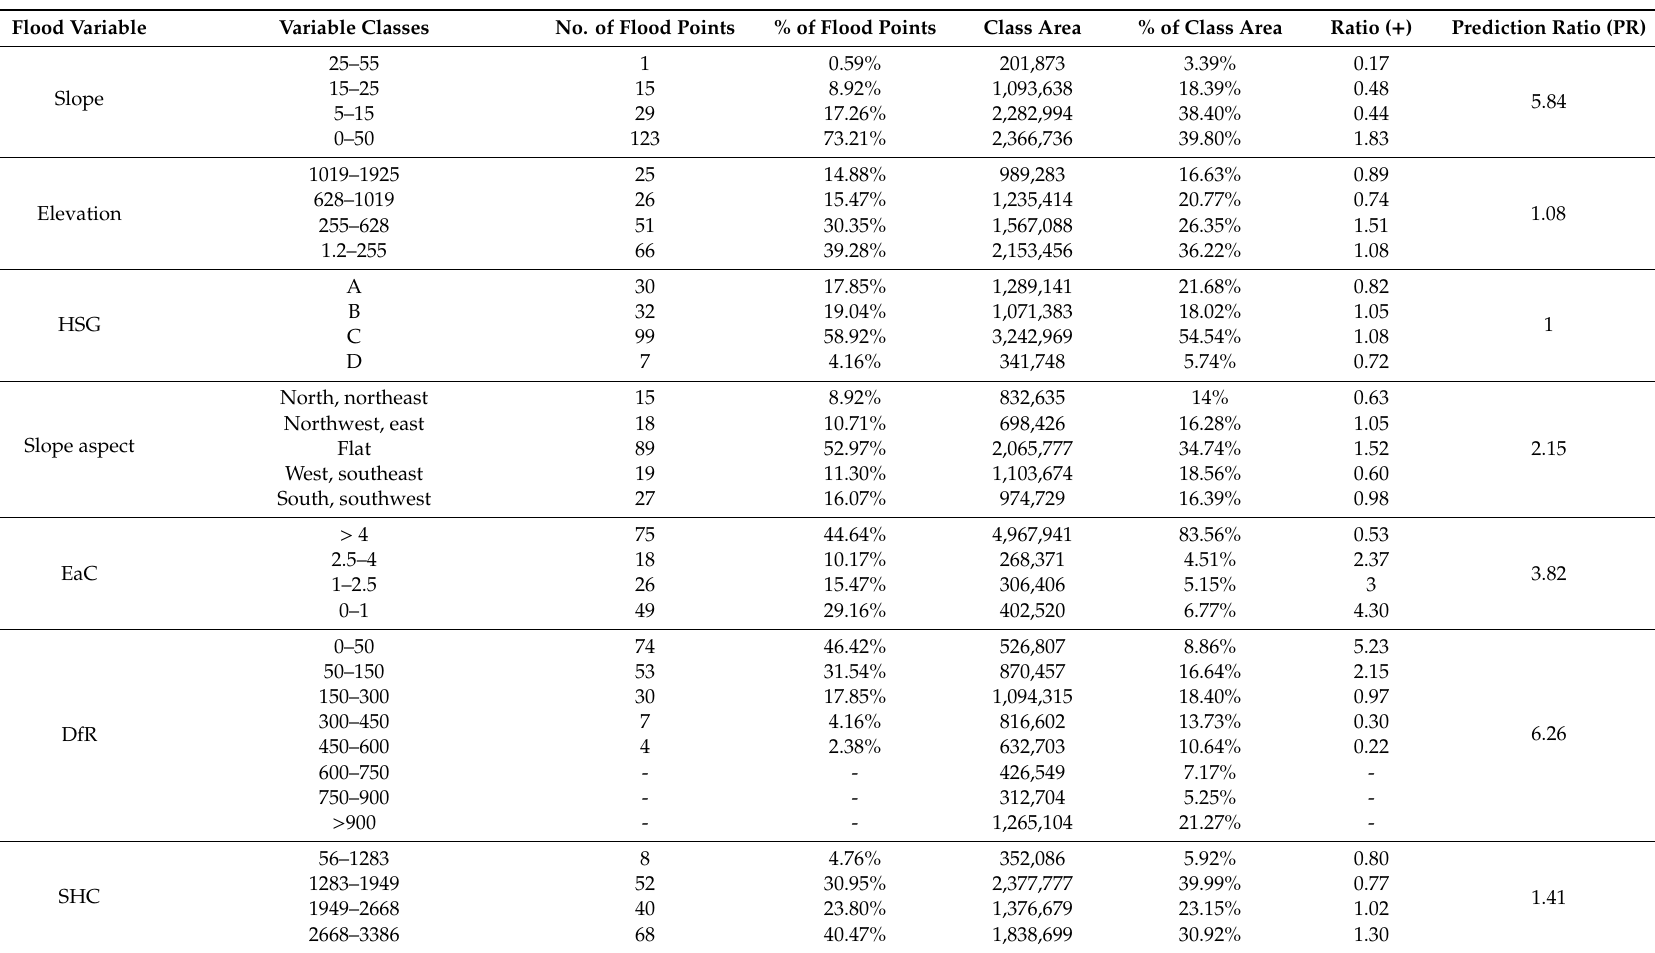
Table 2. Frequency and prediction ratio and the distribution of the flood locations and classes of each flood conditioning variable. EaC: elevation above channel; DfR: distance from rivers; SHC: saturated hydraulic conductivity; DD: drainage density; MaP: multi-annual